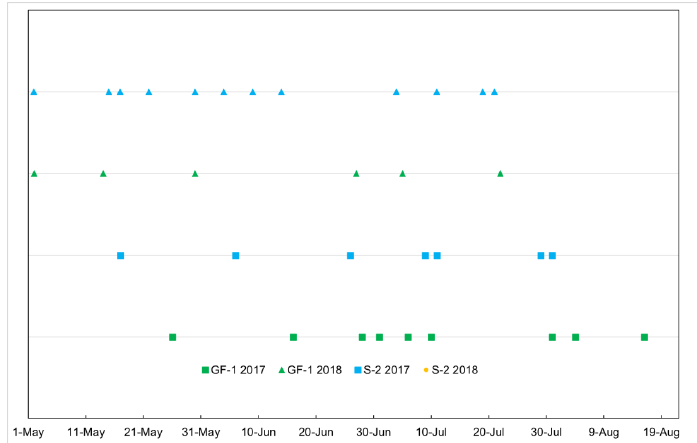
Figure 2. The GF-1 and S-2A/B image data used for the